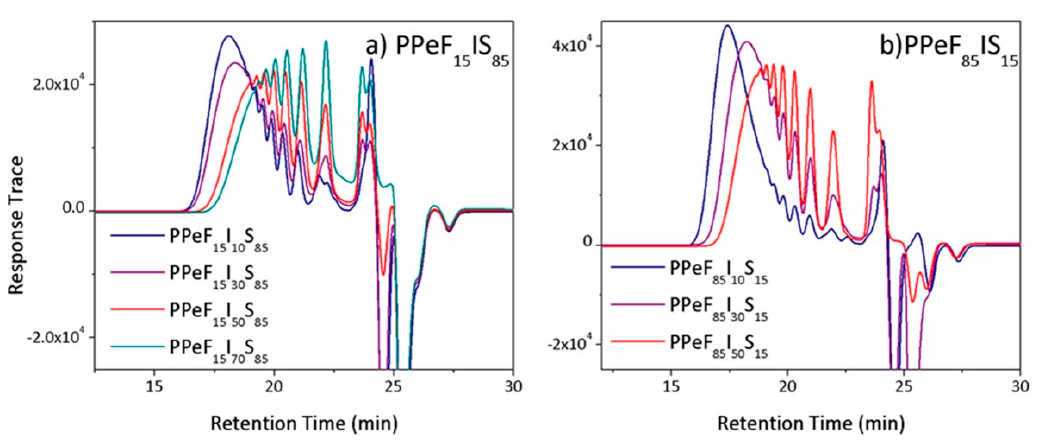
and 3100 Da, indicating the great influence that the addition of isosorbide imparts, which allows a